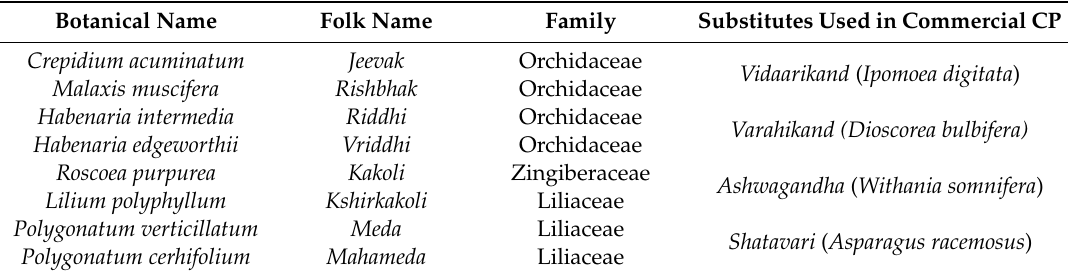
Table 2. Eight “missing” ingredients of CP—the Ashtavarga